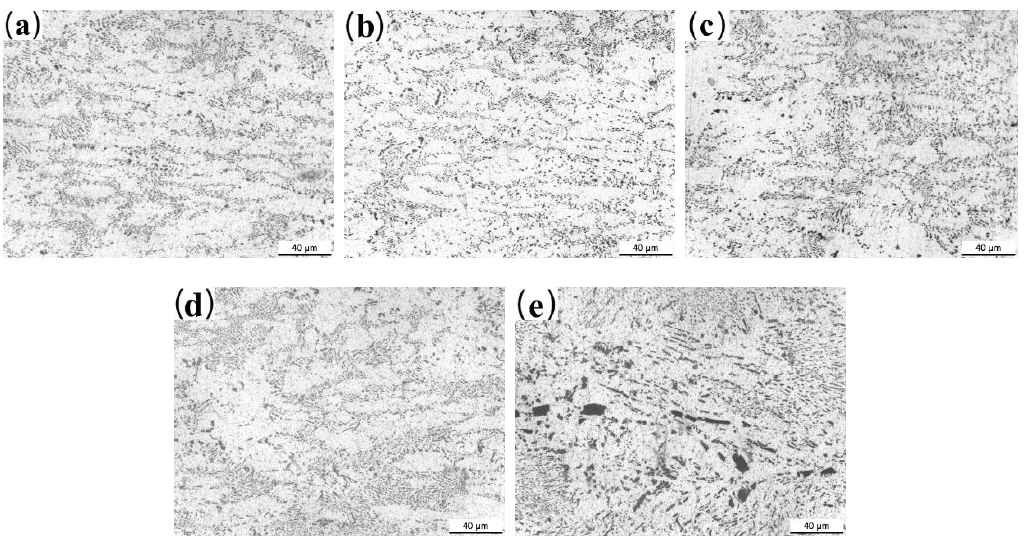
Figure 6. Microstructure of the rolled Al-2Fe- x Co alloys: ( a ) x = 0; ( b ) x = 0.1; ( c ) x = 0.3; ( d ) x = 0.5; ( e ) x = 0.8.